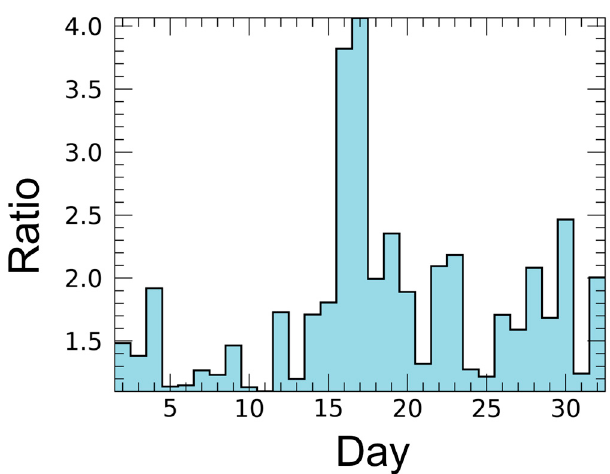
Figure 4. Ratio between the number of valid pixels, in each daily Chl map, derived from GEO and low-Earth orbit (LEO) sensors from May 2016. A valid pixel is defined as a pixel where, at least, a daily Chl mean value has been estimated.